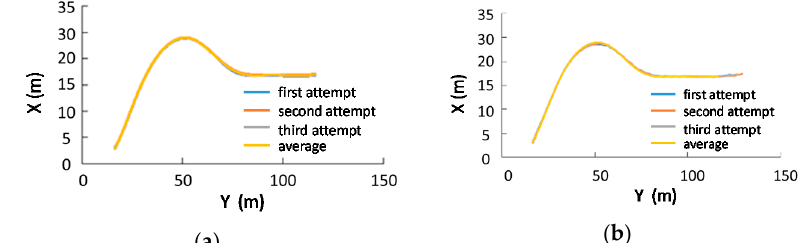
Figure 5. ( a ) The standard curve obtained by walking; ( b ) The curve obtained from the downhill cornering experiment with the bike using the complementary